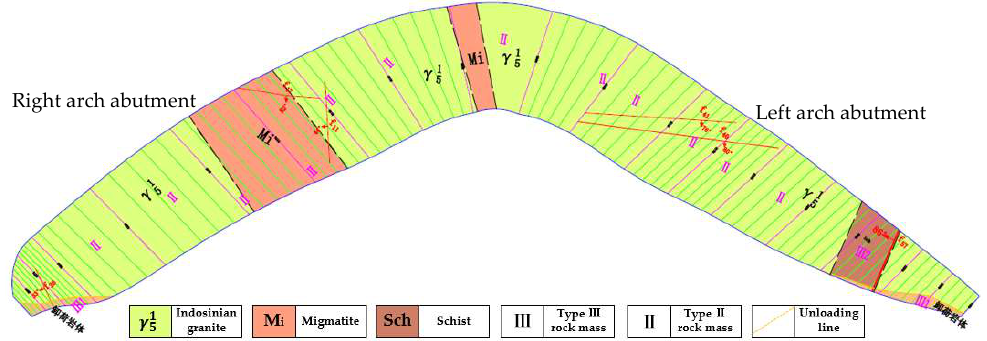
Figure 5. Bedrock distribution of the foundation surface.